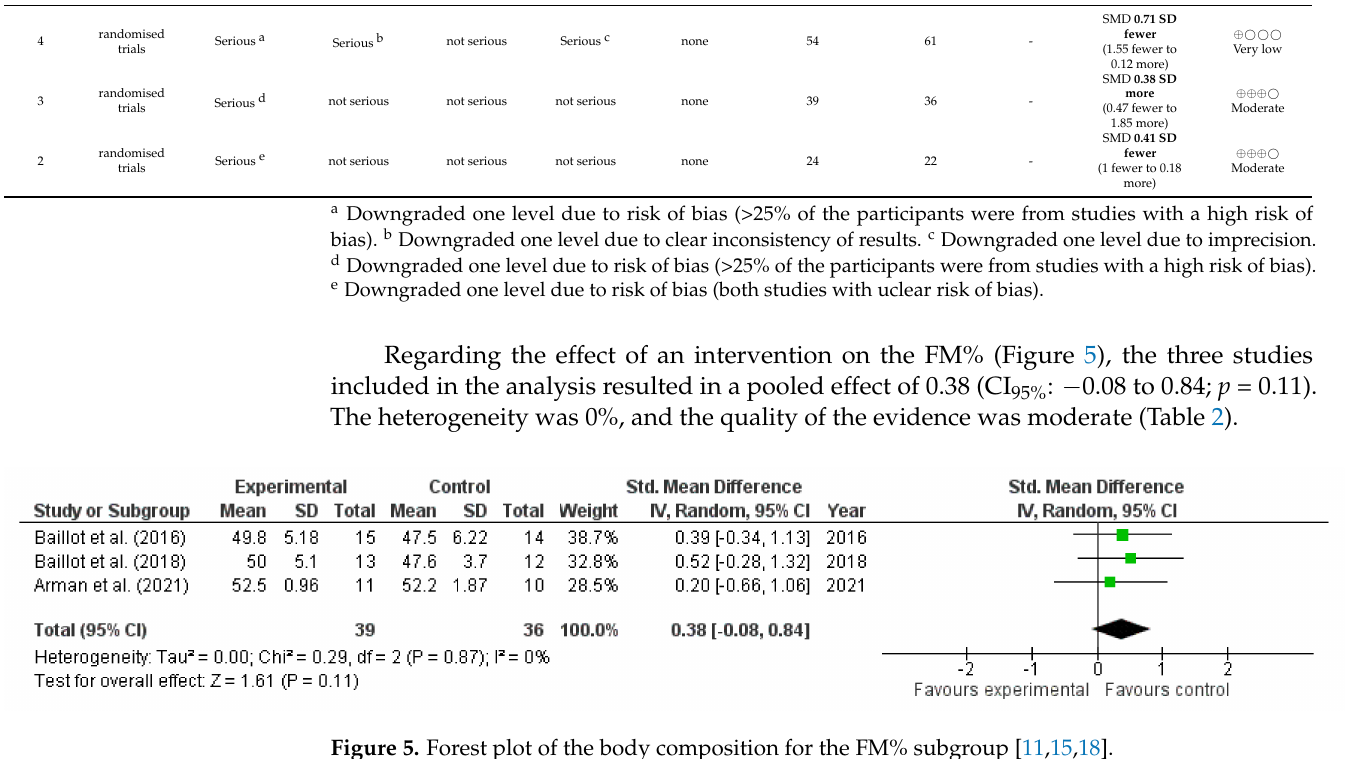
Figure 5. Forest plot of the body composition for the FM% subgroup [11,15,18].